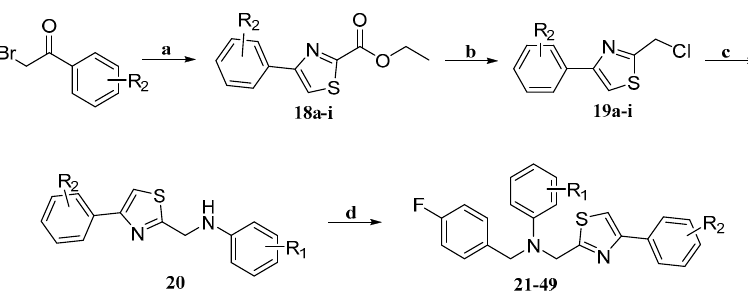
Scheme 2. Synthesis of target compounds 21 to 49 . Reagents and conditions: ( a ) Ethyl